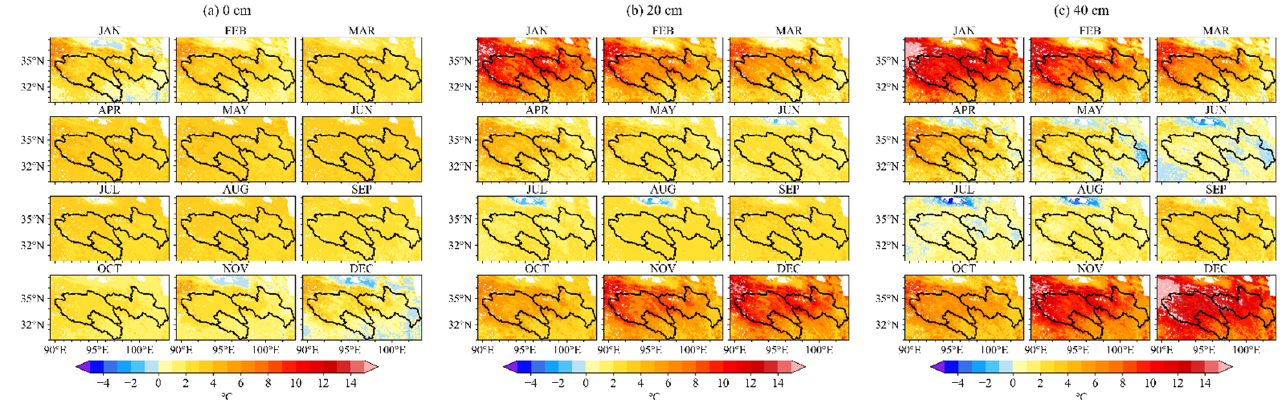
Figure 10. The difference between soil temperature and air temperature at ( a ) 0 cm, ( b ) 20 cm, ( c ) 40